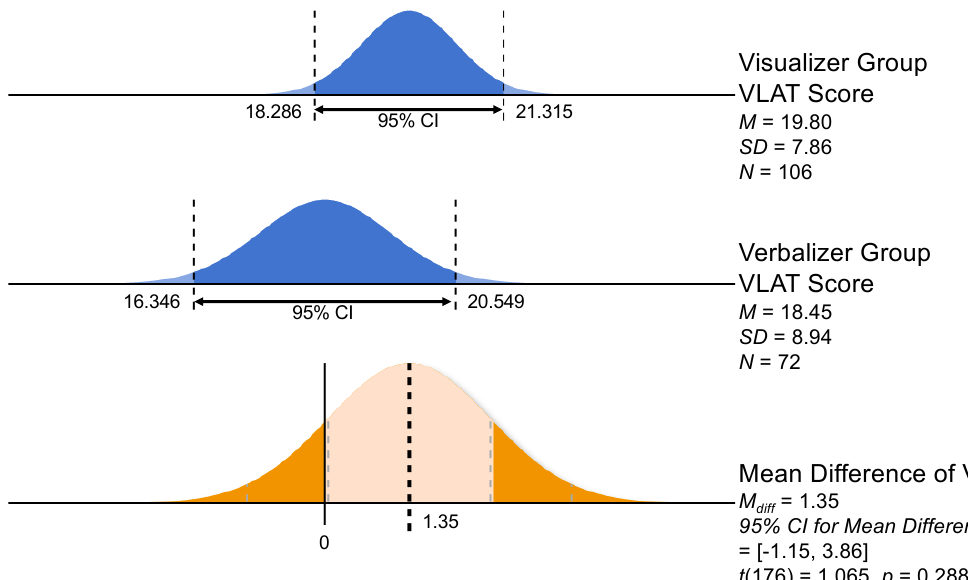
Figure 5. Difference in VLAT scores between visualizer user group and verbalizer user